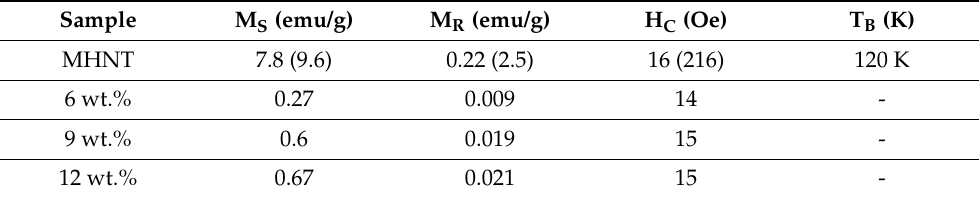
Table 2. Summary of magnetic properties of magnetized HNTs and prepared nanofibers at 300 K. In brackets are values for MHNT measured at 2